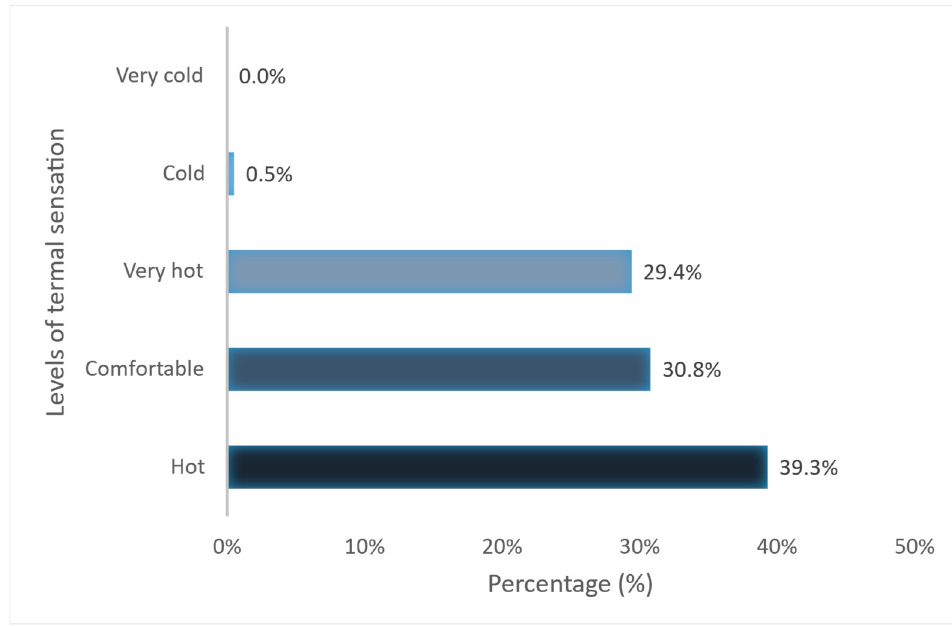
Figure 15. Levels of thermal sensation of the respondents.